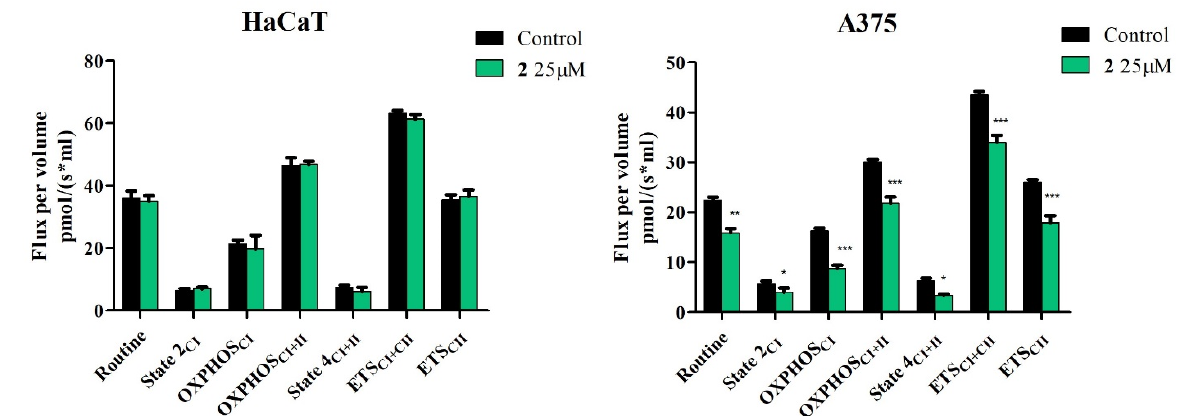
Figure 9. Respiration of permeabilized immortalized human keratinocytes (HaCaT) and human melanoma cells (A375) following 24 h stimulation with 25 μ M 2 . Data represent the mean ± SD of five individual experiments. Values with p < 0.05 were considered to have statistically significant differences (* p < 0.05, ** p < 0.01, and *** p < 0.01). The respiratory parameters displayed represent